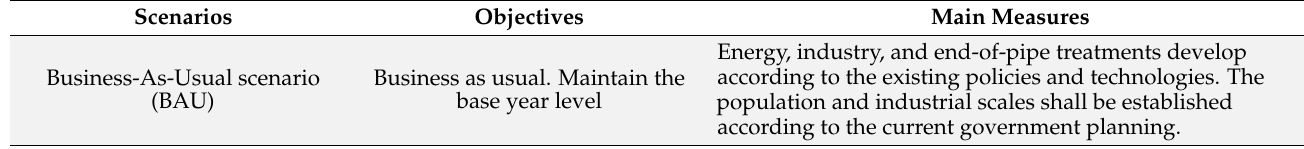
Table 1. Scenario